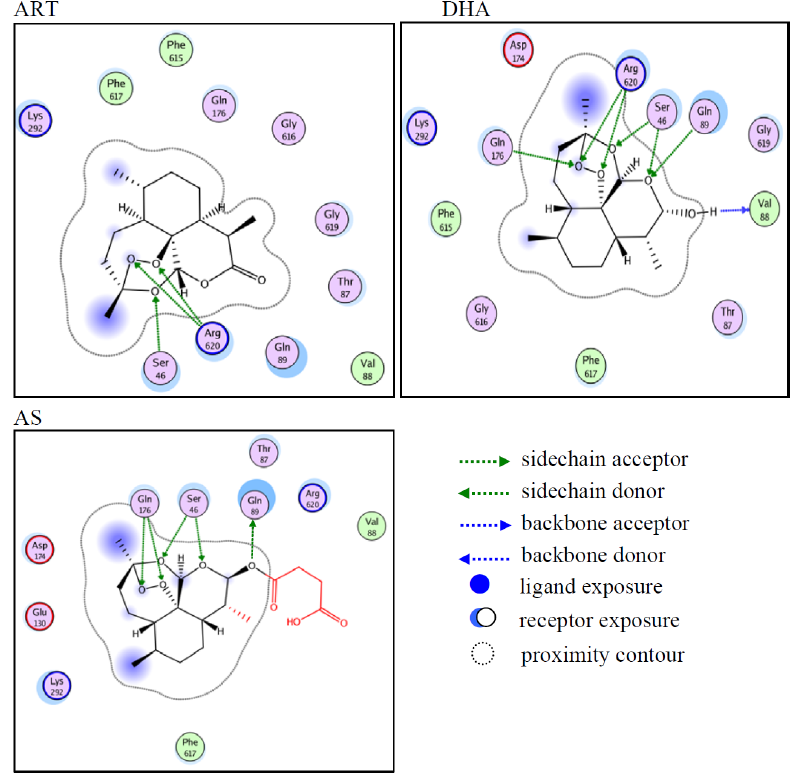
Figure 1. Proposed molecular docking details between AcrB and the ligands. The interactions of AcrB:ART, AcrB:DHA, and AcrB:DHA are respectively shown in A, B, and C. The residues closed to proximity contour of ligands are shown in colored circles. The ligands are shown in plane carbon skeleton models with the proximity contours. The proposed hydrogen bonds between residues of AcrB and ligands are shown in arrows. Both ligand and receptor exposures are shown in circular